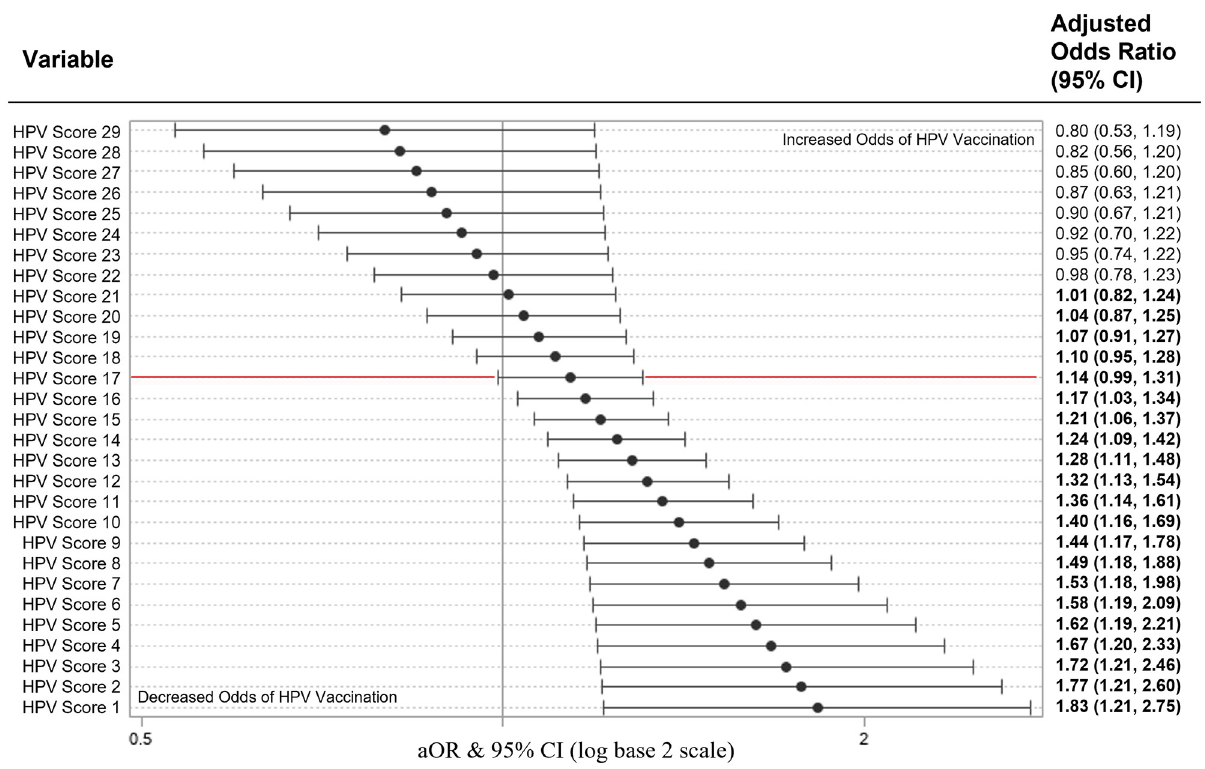
Fig 2. HPV score as a predictor of HPV vaccination in multivariate logistic regression (model 1, n = 84). HPV Score as a predictor of HPV vaccination in a multivariable logistic regression model containing age, race, ethnicity, educational attainment, current contraceptive use, number of sexual partners, and HPV score. HPV Score (p = 0.009) and higher order quadratic term of HPV Score (p = 0.034) are significant predictors of HPV vaccination. Single score changes beyond an HPV score of 16 are not associated with HPV vaccination. Adjusted Odd Ratios of adverse events were calculated and presented using a log base 2 scale in a Forest Plot. Null line is indicated for no predictor effects and bolded lines represent adjusted odds ratio with 95% confidence intervals. Bolded lines above and below the null line indicate increased or decreased odds of adverse events, respectively.